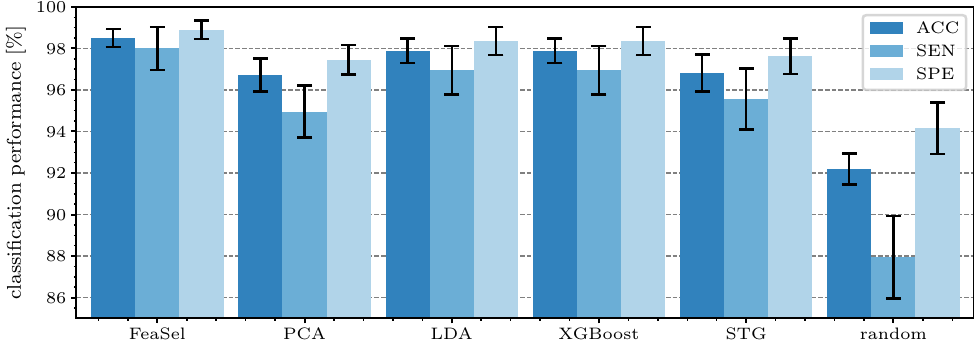
Figure 12. Discriminability in classifications with a subset of the original features according to the findings in Table 2. Each subset has the size p = 3. The classifier and parameters are identical for all